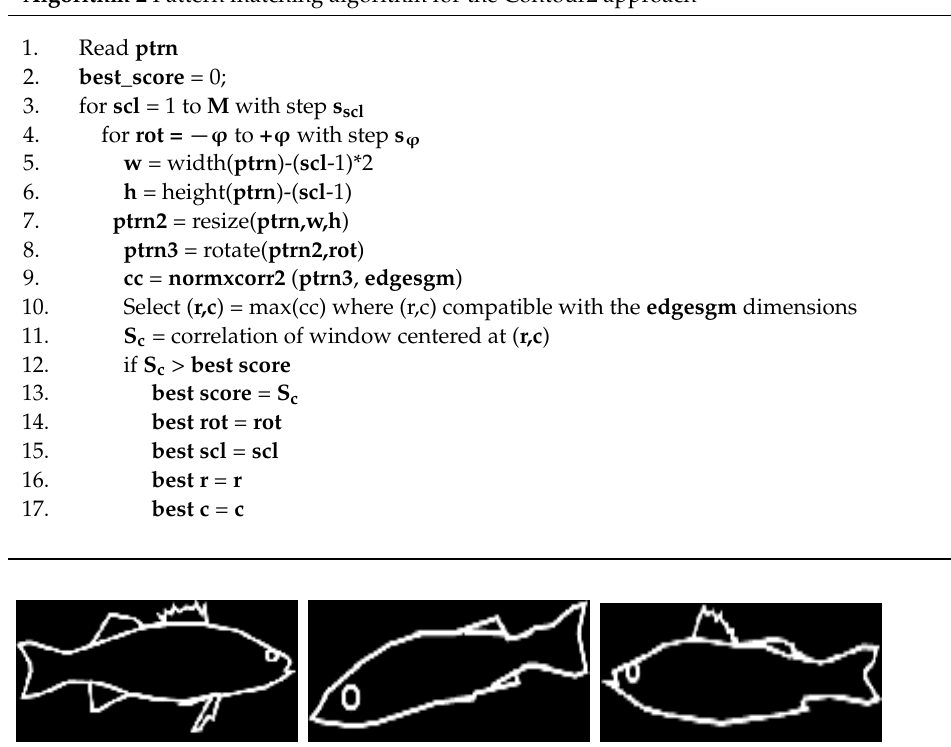
Figure 7. The three patterns used for sea bass.